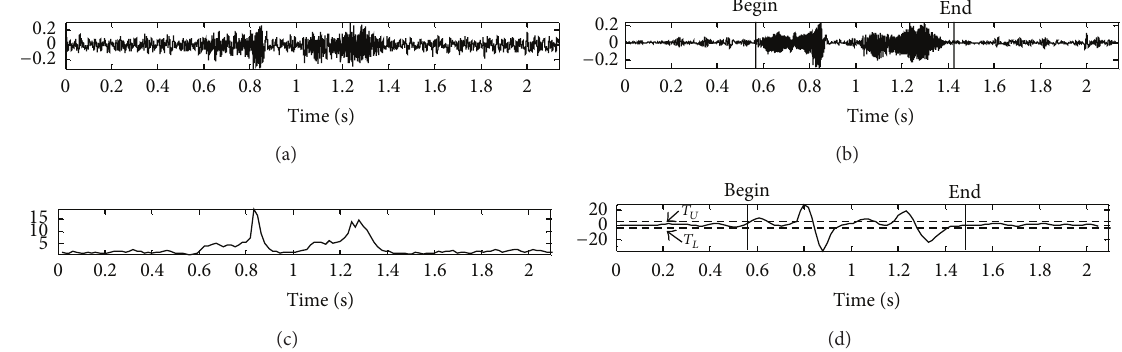
Figure 11: Results of the proposed algorithm in the environment of high speed driving on highway: (a) noisy speech signal at SNR − 8dB, (b) speech obtained manually by applying noise reduction [19] to (a) signal, (c) the proposed feature, and (d) edge detection filter output based on the proposed